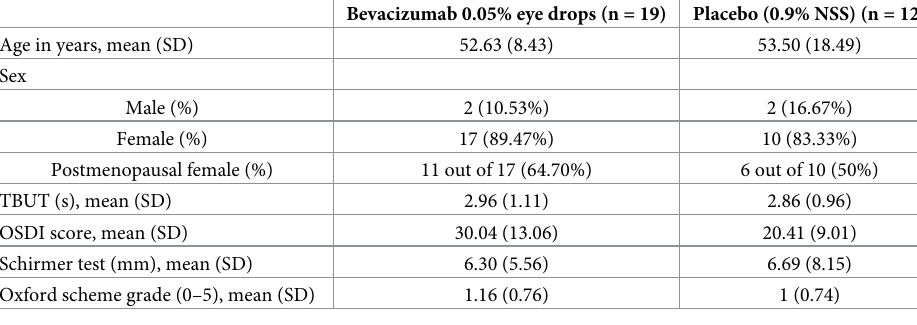
Table 1. Baseline demographics and clinical